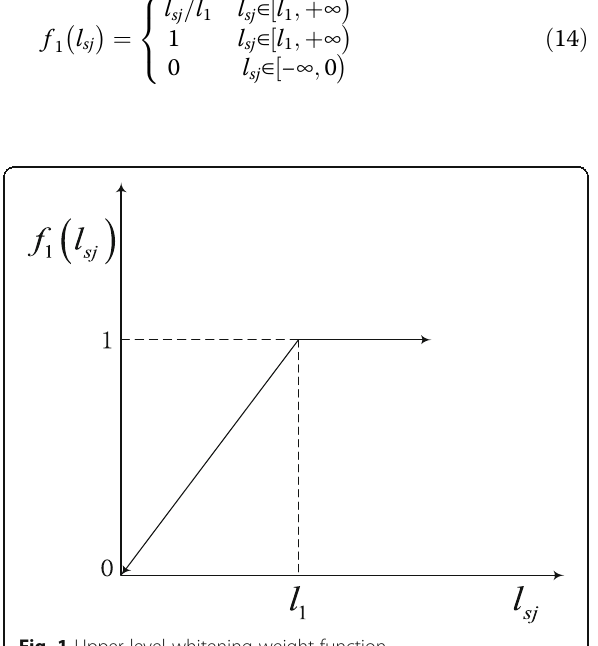
Fig. 1 Upper-level whitening weight